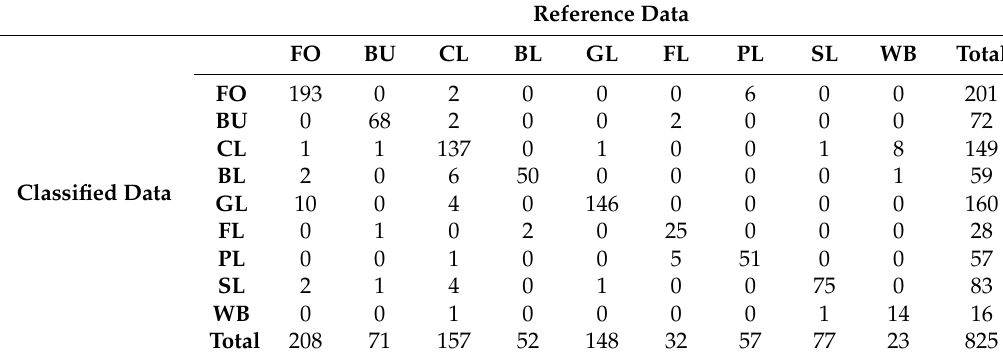
Table 2. Error matrix or confusion matrix for the accuracy assessment of the LULC map of the Godavari River Basin.